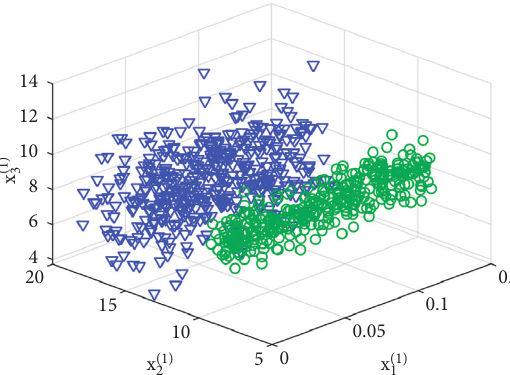
Figure 7: Comparison of the cluster data set with a noise feature.